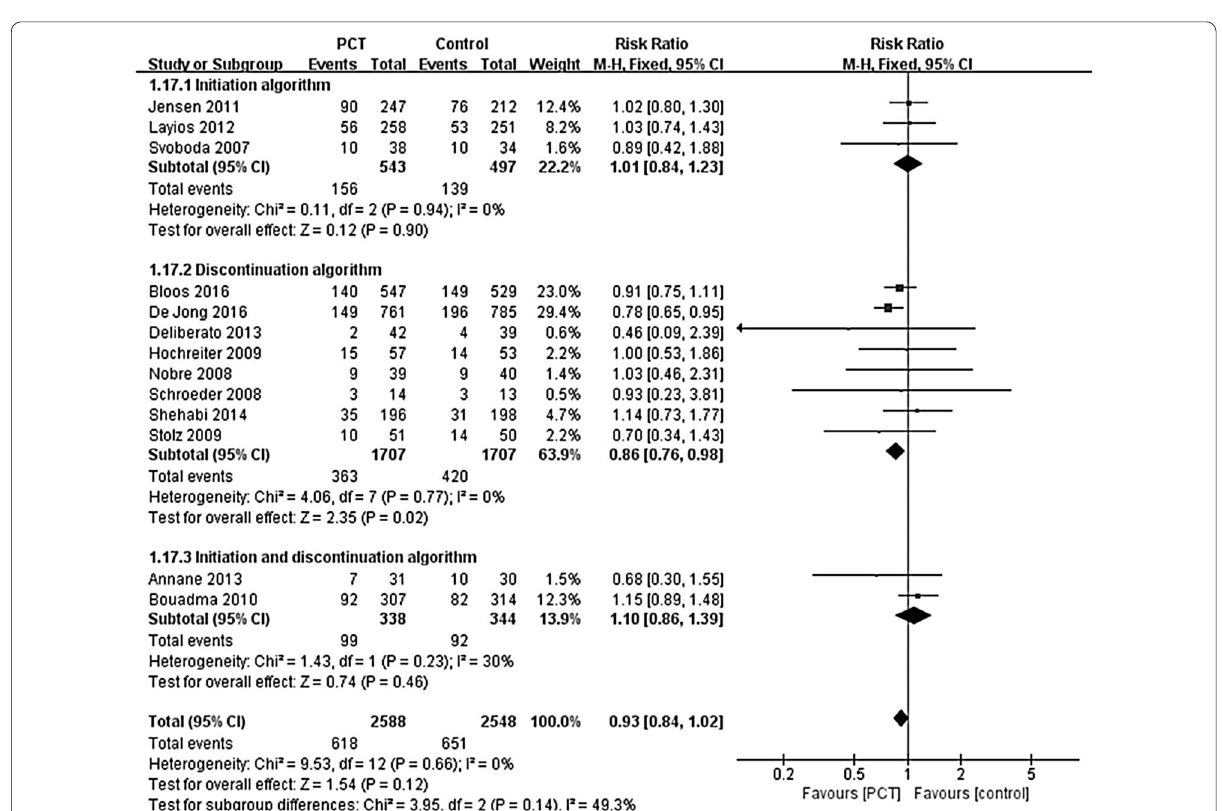
Fig. 3 Effects PCT‑guided antimicrobial strategies on short‑term